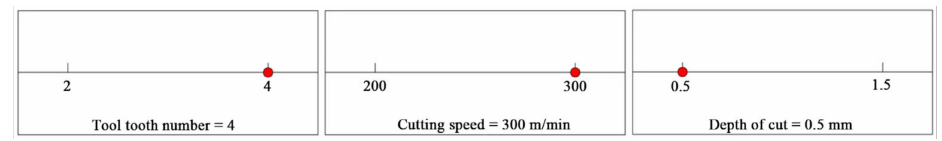
Figure 8. Optimal milling